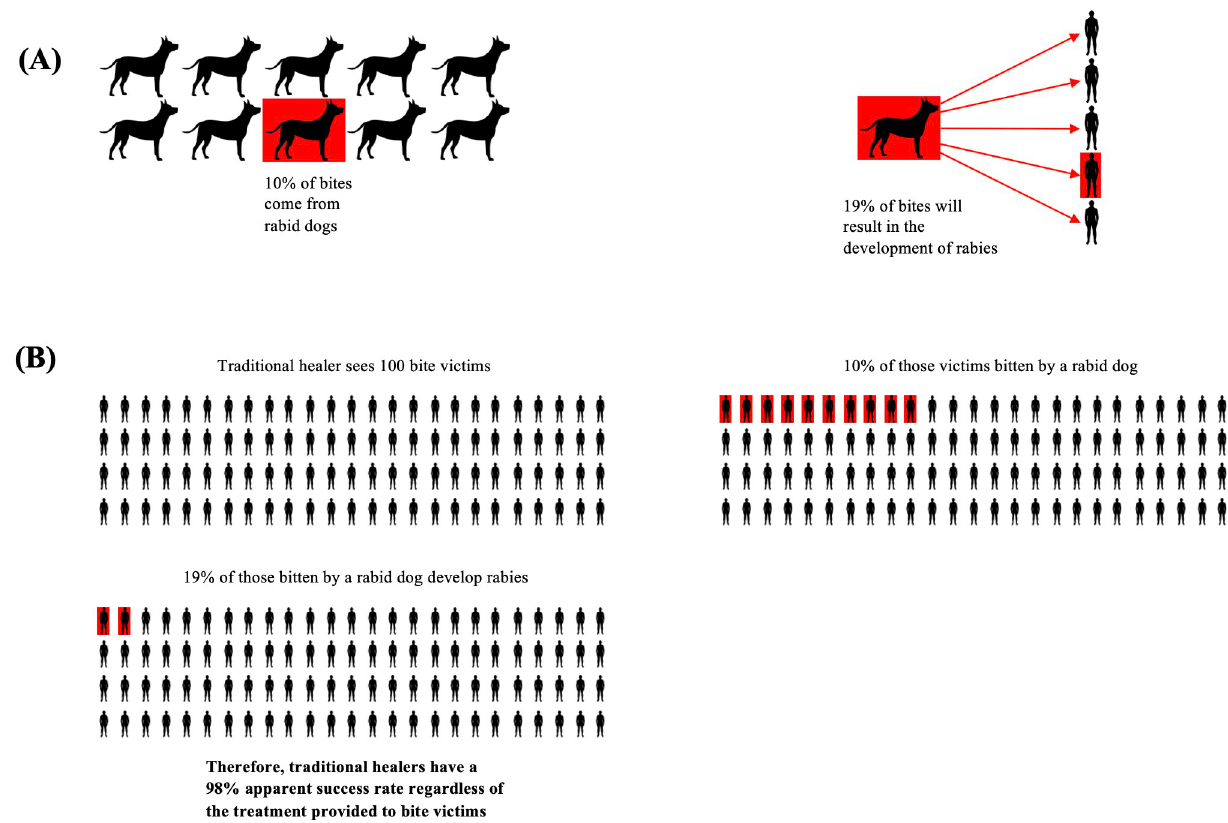
Fig 2. Diagram of frequencies of dog bites from rabid dogs and those bites causing clinical rabies. (A) An estimated 19% baseline value of dog bites develop into clinical rabies in humans. (B) Traditional healers treat dog bite victims, and due to the 10% estimated baseline value of bites from a rabid dog, the traditional healers have an extremely high apparent success rate of 98% of victims surviving a suspected rabid dog bite (diagram showing a population of